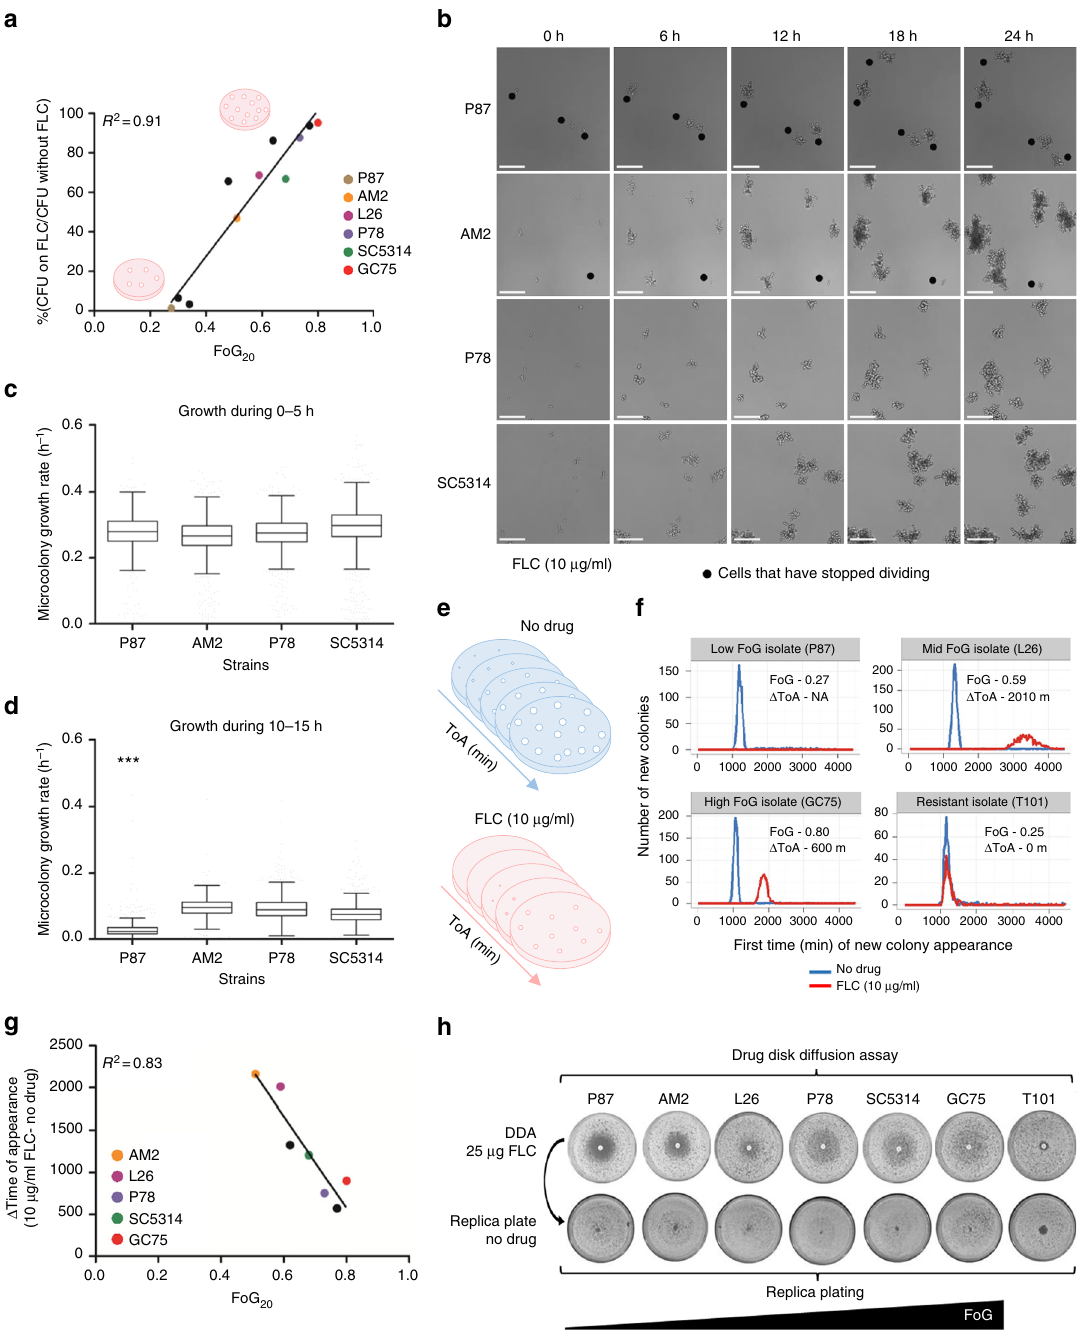
Fig. 2 Analysis of cells growing at supra-MIC concentrations. All tested strains, except for T101 (MIC = 64 µ g/ml), had FLC MIC values below 10 µ g/ml. a FoG correlates with the proportion of colonies that grow on 10 µ g/ml FLC relative to growth on plates without drug. Black dots are additional strains from Fig. 1c. b Microcolony analysis at supra-MIC concentrations of FLC (10 µ g/ml). Symbols indicate cells that have stopped dividing in the presence of drug over 24 h, scale bars = 100 µ m. On average, strain AM2 formed fewer microcolonies than strain SC5314, but these were larger than those formed by SC5314. Time-lapse videos are available as Supplementary Movies 1 – 4. c , d Growth rate analysis of cells growing at supra-MIC FLC (10 µ g/ml) during 0 – 5 h ( c ) and 10 – 15 h ( d ). e Schematic of ScanLag analysis 75 that measures time of colony appearance (ToA), colony growth rate, and colony size using desktop scanners. f ToA on medium without drug (blue) or with 10 µ g/ml FLC (red) for resistant isolate T101, and isolates with different FoG levels. Graphs show the number of colonies ( y -axis) at each time point ( x -axis). Additional isolates are included in Supplementary Fig. 4. g Correlation between FoG 20 and the difference ( Δ ) in the ToA of colonies in the presence vs. absence of FLC ( Δ ToA = ToA with FLC – ToA without FLC). Black dots are additional strains from Fig. 1c. h Cells that grow within the zone of inhibition are viable, as seen by replica plating of disk diffusion assays grown on casitone without FLC and incubated at 30 °C for 48 h. For all panels, n ≥ 2; *** P < 0.001; error bars denote standard